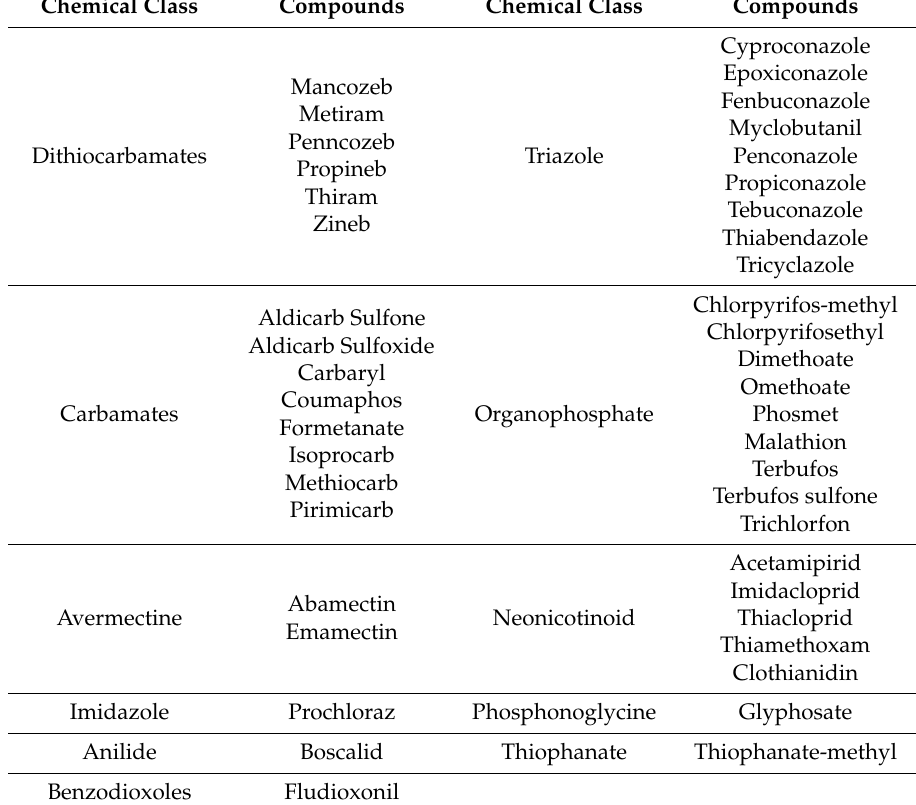
Table 1. Pesticides analysed in food